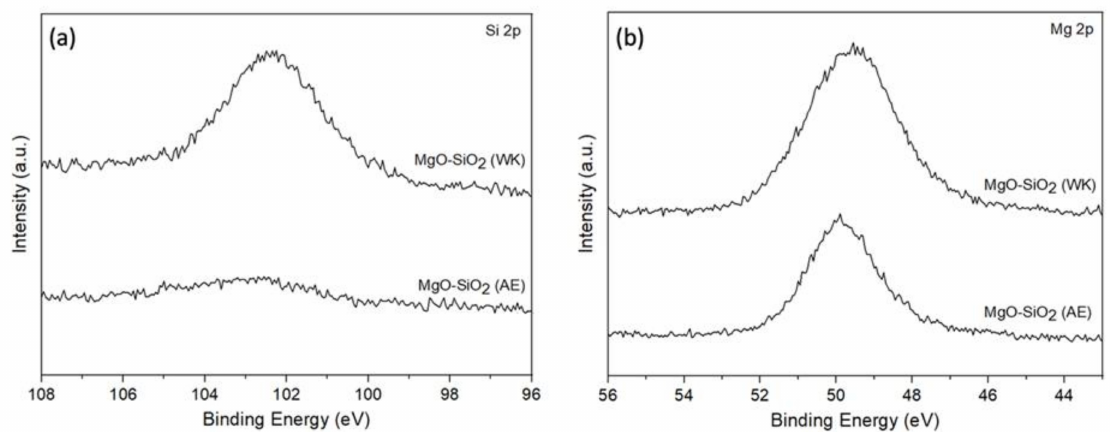
Figure 5. XPS spectra of the ( a ) Si 2p and ( b ) Mg 2p regions for MgO-SiO 2 prepared by ammonia evaporation (AE) and wet-kneading